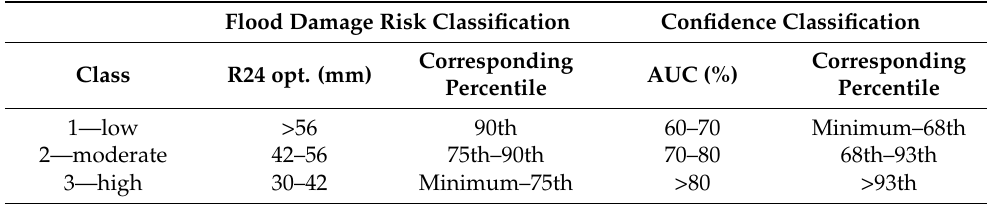
Table 5. Specifications for the classification of flood damage risk and confidence in discriminating performance of the estimated R24